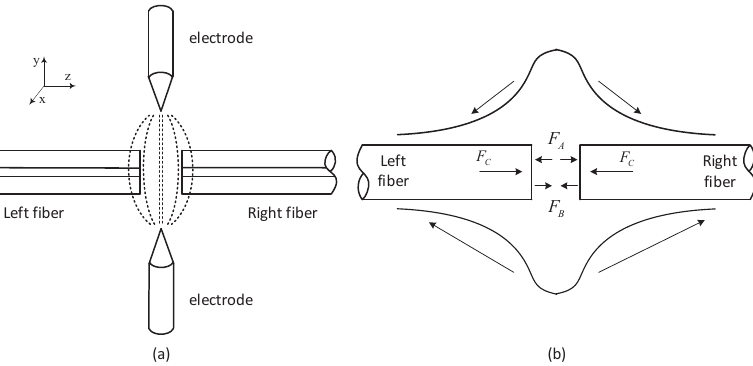
Figure 2. Schematic diagram of single-mode fiber fusion-splicing, ( a ): optical fiber fusion splice, the axis direction of the optical fiber is located in the Z-axis direction, and dotted line shows the two electrodes discharge and heat the two optical fibers simultaneously; ( b ): thermal and mechanical properties of the process of fusion-splicing; F A represents the surface tension of the end face of the optical fiber; F B represents the force exerted by the fusion splicer; F C represents the thermal expansion force; the gravity F g is not drawn here, and the heat source is transmitted along the axial direction of the two optical fibers and gradually weakens.